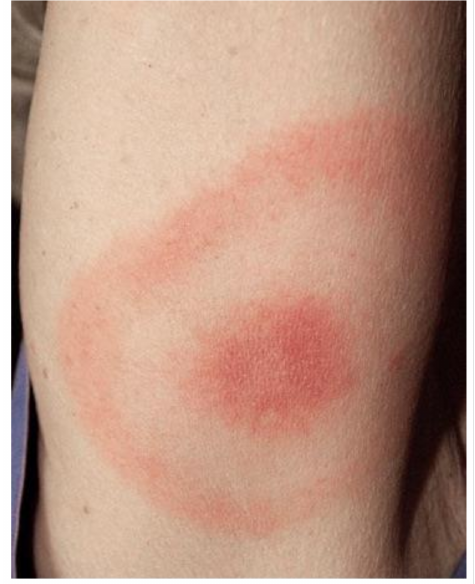
Figure 7. Erythema migrans of the leg (photo by G. Trevisan).